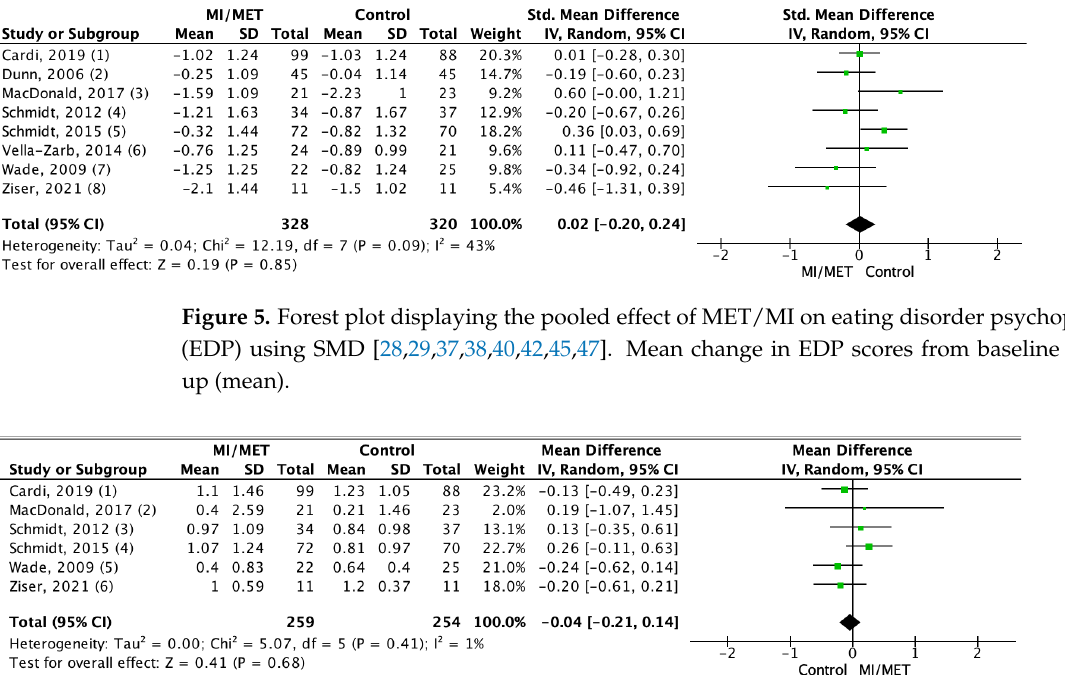
Figure 6. Forest plot displaying the pooled effect using the mean difference (MD) of MET/MI on BMI. Mean = mean change in BMI from baseline to follow-up.